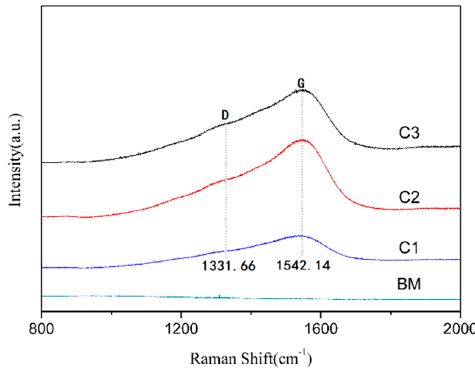
Figure 3. Raman scattering spectra of the carbon films.